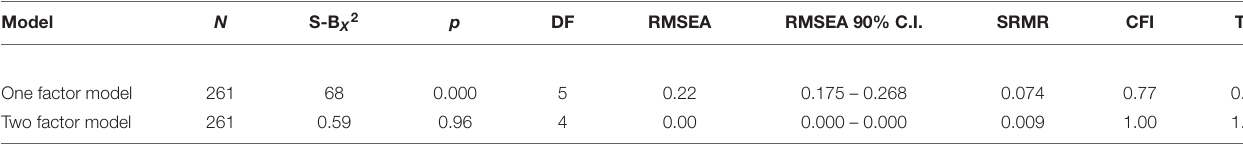
TABLE 1 | Unidimensional and two factor model of physical fitness construct.